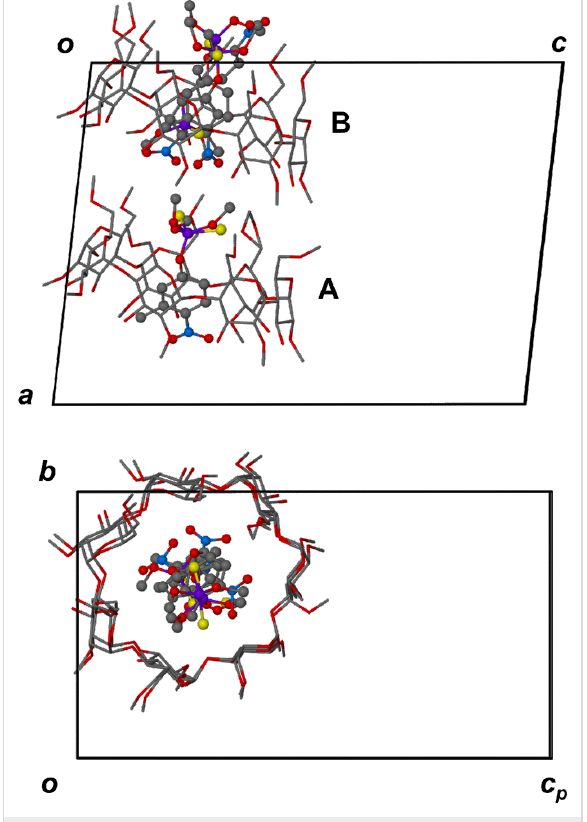
Figure 3: The asymmetric unit in DIMEB• 1 viewed along [010] (top) and [100] (bottom). H atoms are omitted for clarity.